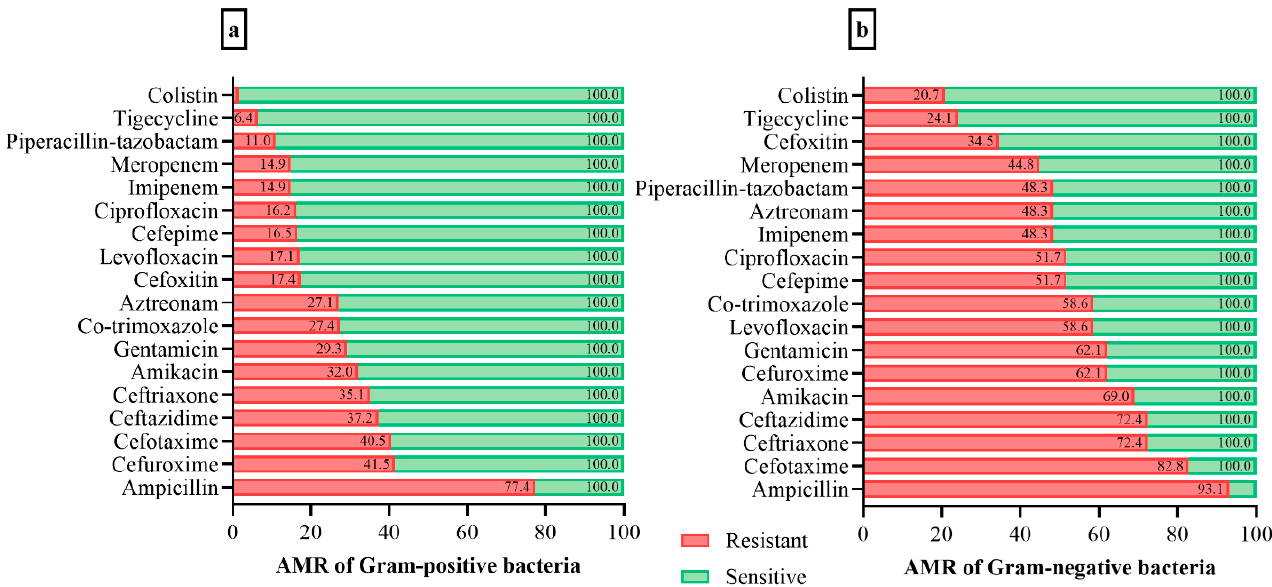
Figure 1. Antimicrobial resistance (AMR) of bacterial isolates from food products. Red bars indicate resistance and green bars susceptibility. ( a ) Gram-positive bacterial isolates; and ( b ) Gram-negative bacterial isolates.